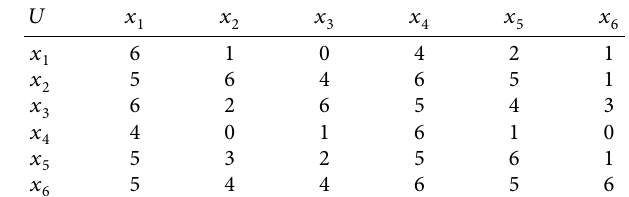
Table 1: Tabular representation of ( H,E ) .